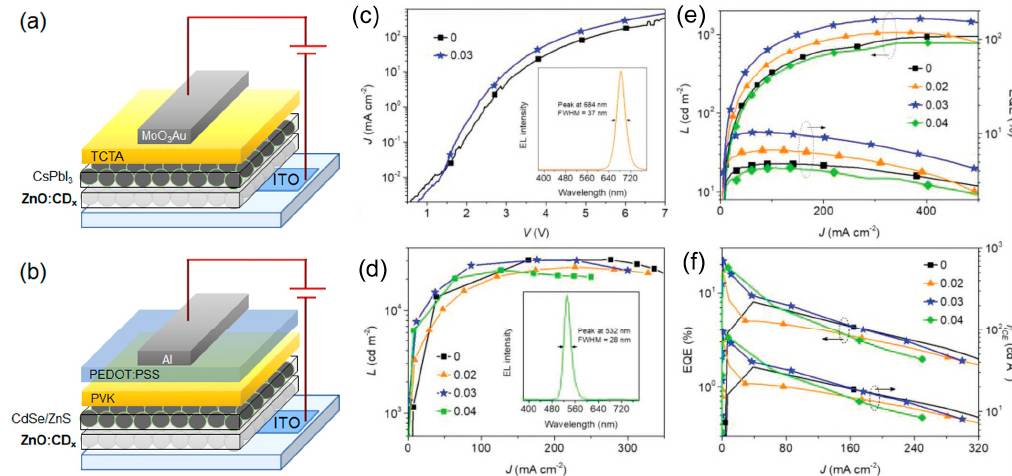
Figure 24. ( a ) CsPbI 3 and ( b ) CdSe/ZnS QD-LED device architectures; ( c ) J-V of CsPbI 3 QD-LEDs with or without CDs (concentration 0.03 mg/mL in ZnO and CD x being molar ratios of the CA and EDA precursors) interface modifier, with the EL spectrum of the LED employing the CD (0.03 mg/mL) modifier given as an inset; ( d ) L-J of CdSe/ZnS QD-LEDs modified with different concentrations of CDs as given on the frame (in mg/mL), with the EL spectrum of the LED employing the